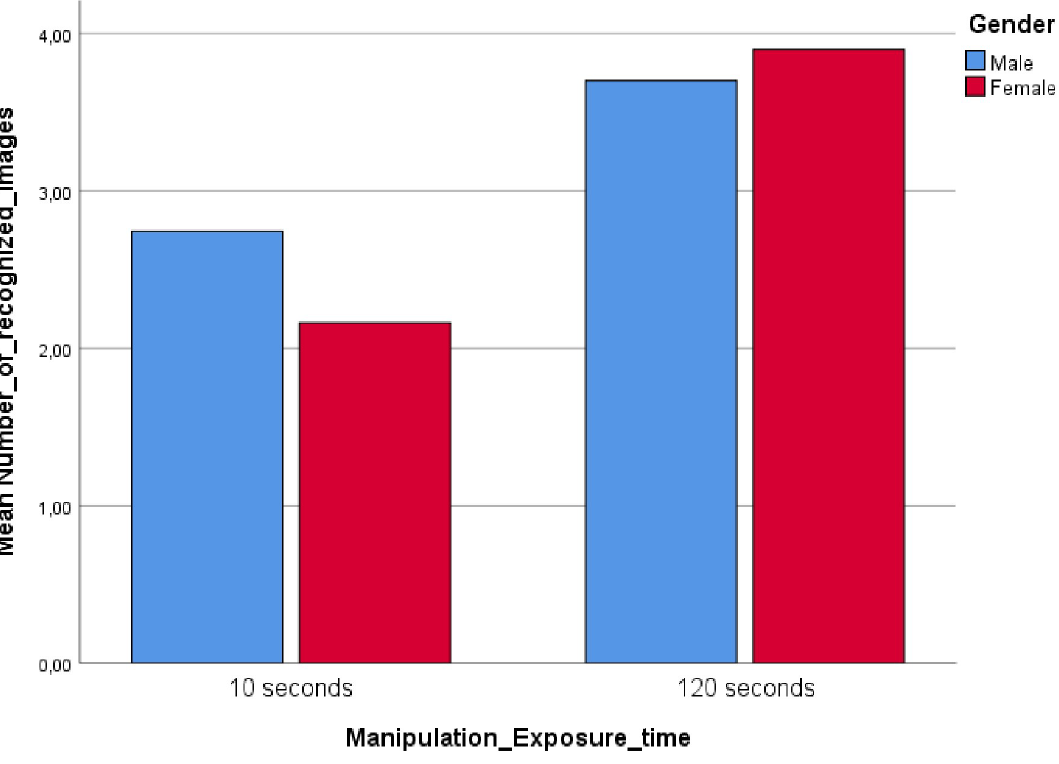
Fig 2. Study 2: Interaction between exposure time and gender.